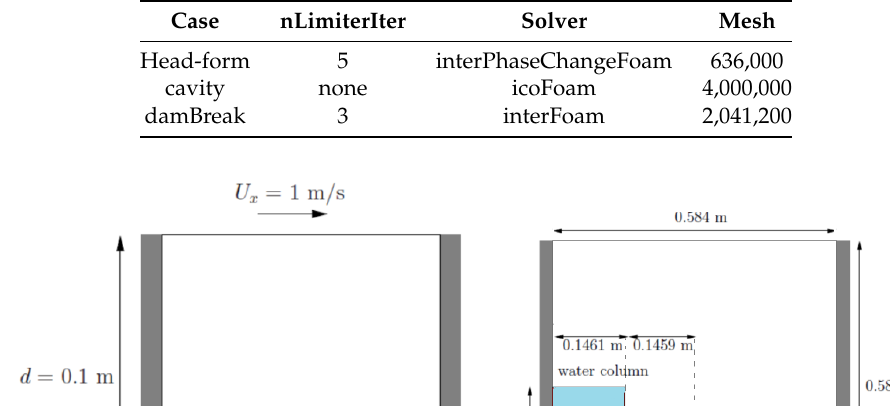
Table 7. Configuration of the test case.